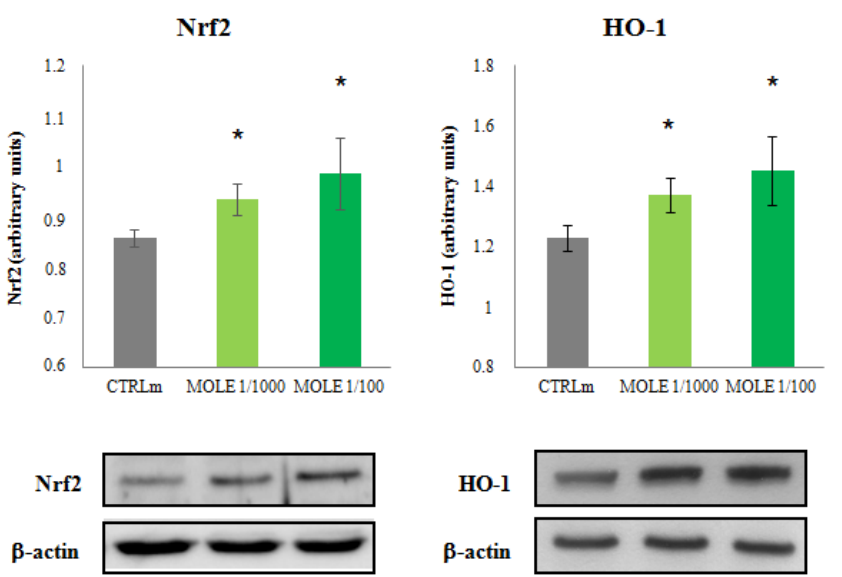
Figure 4. Western blot analysis. Measurement of Nrf2 and HO-1 protein levels analysis was per- formed in C2C12 myotubes after 24 h MOLE (1/1000 and 1/100 working solutions) treatments. Image J densitometric analysis of the Nrf2 and HO-1/ β -actin ratios from the immunoblots is shown (the images are a representative of the experiments). Data presented are the mean ± SD of three experiments. * p < 0.05 vs. CTRLm.